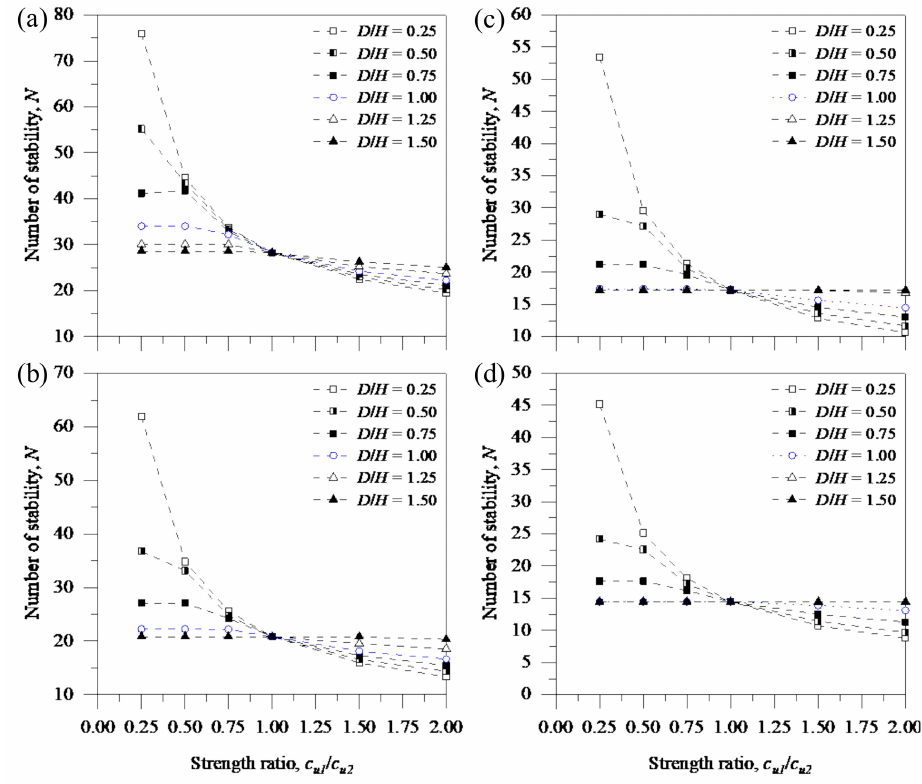
Figure 14. The e ff ect of the strength di ff erence between two layers, where T / H = 2, H / B = 0.5 ( a ) β = 15 ◦ , ( b ) β = 30 ◦ , ( c ) β = 45 ◦ , and ( d ) β = 60 ◦